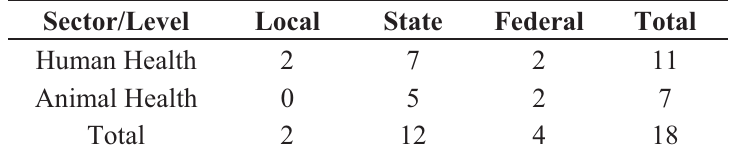
Table 1. Response Information for Survey/Interview by Level of Government and Sector.